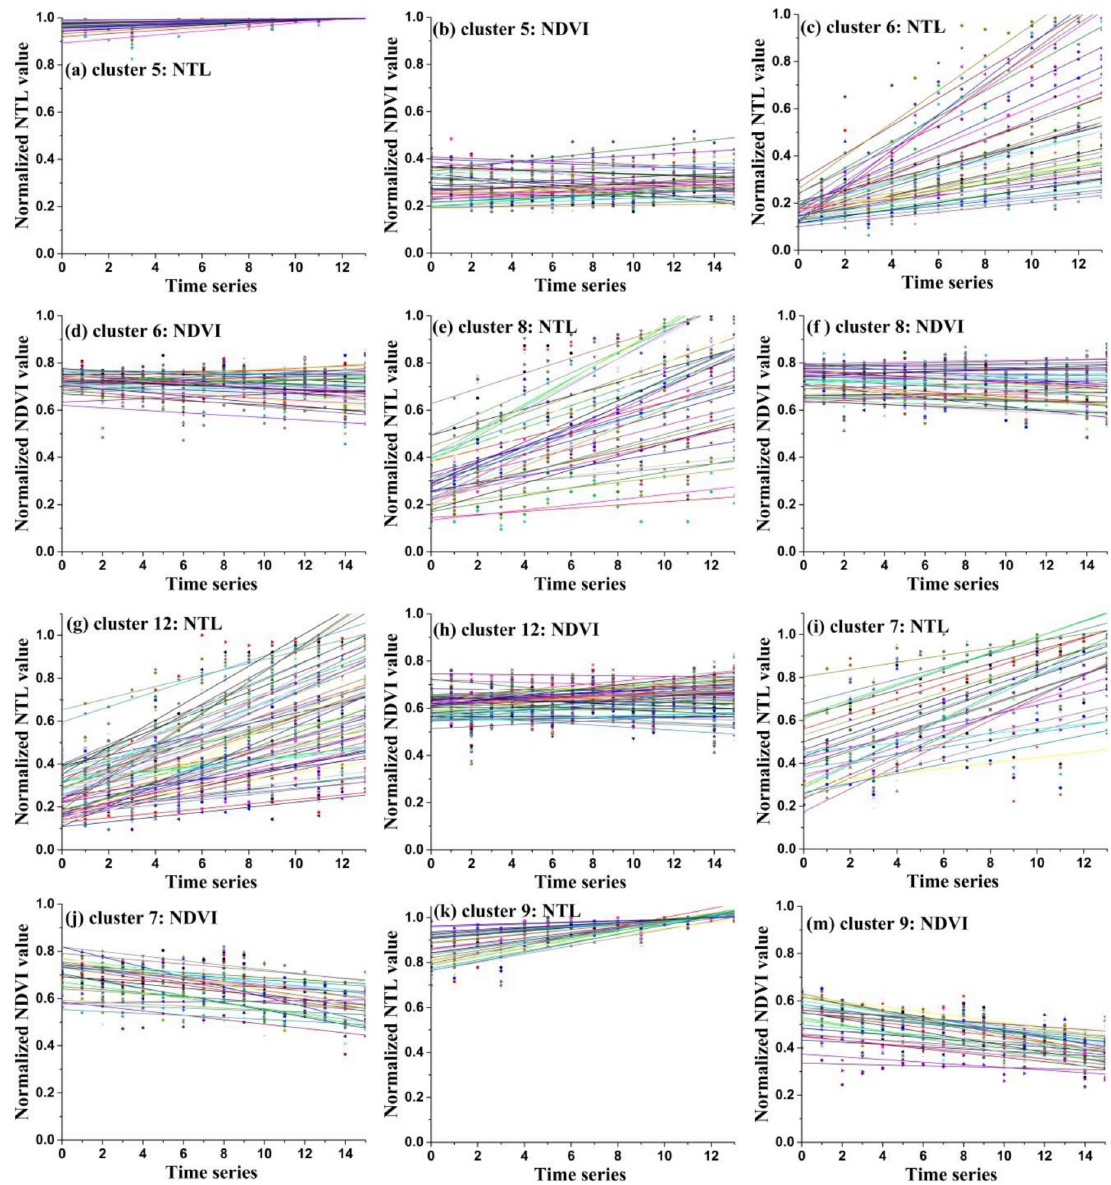
Fig 7. The linear model lines of the samples of cluster 5, cluster 6, cluster 7, cluster 8, cluster 9 and class